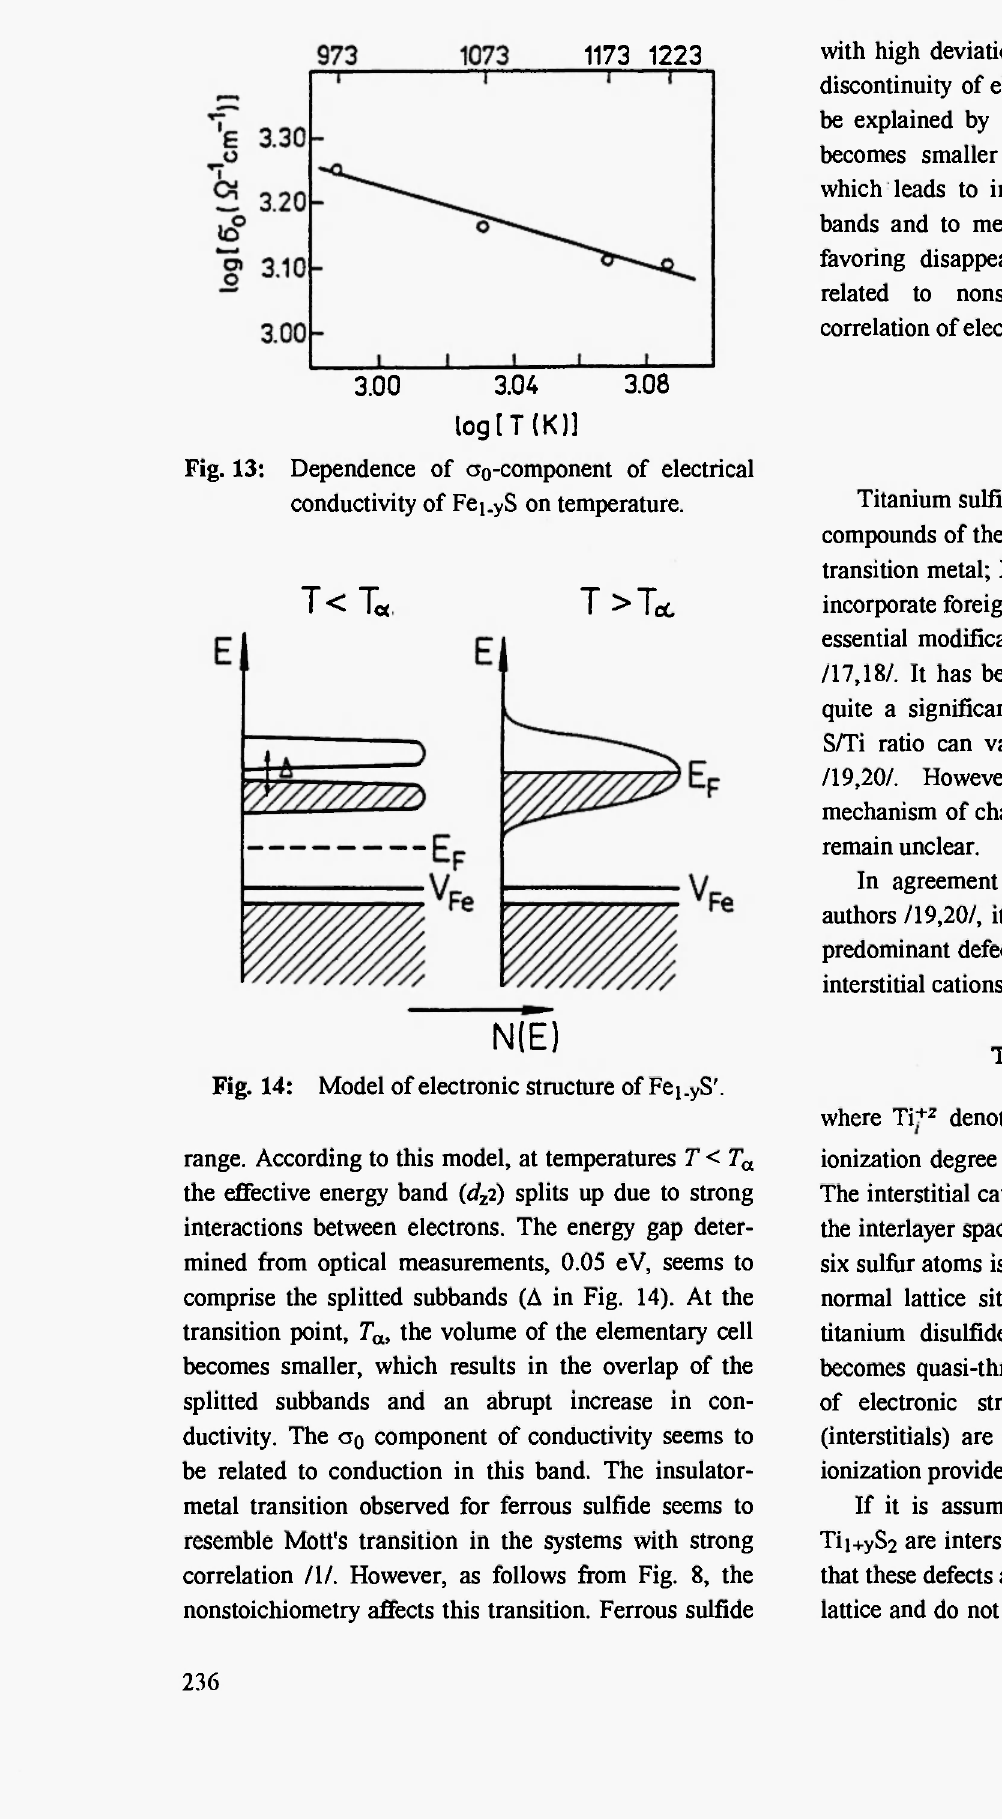
Fig. 13: Dependence of σο-component of electrical conductivity of Fej.yS on temperature.